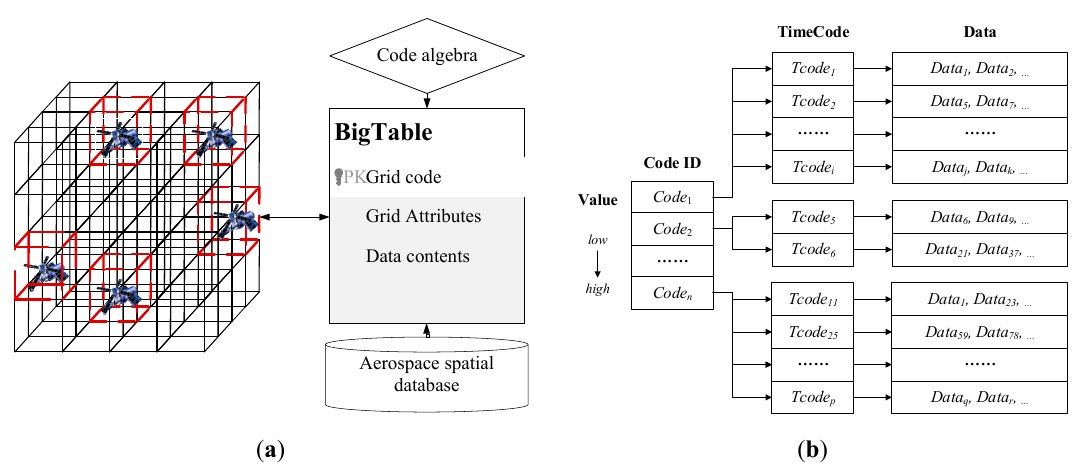
Figure 3. Aerospace storing model and indexing method: ( a ) aerospace storage model; ( b ) spatio-temporal secondary indexing method.